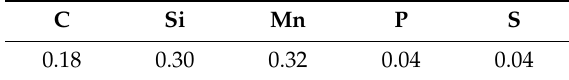
Table 1. Chemical composition of steel St3SX (S235JRG1) ( % ) .